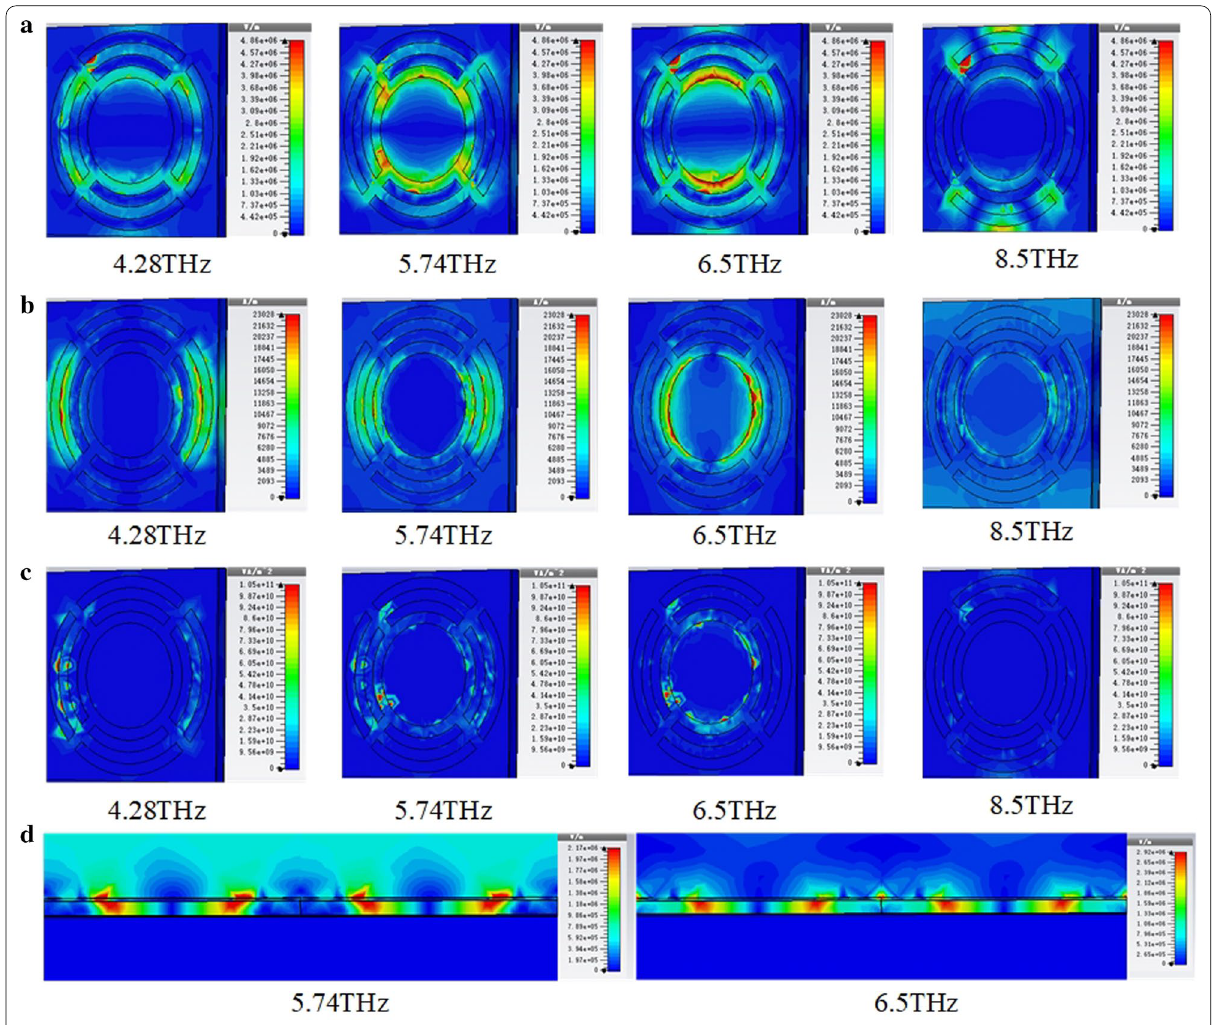
Fig. 4 Top view of electric field density distribution ( a ), magnetic field density distribution ( b ), power loss ( c ) and sectional view of electric field density distribution ( d ) in the periodic structure of two split-rings combined with an Al disk at different resonance absorption frequencies. The periodic structure has a thickness of 10 nm. The two split-rings have a ring width of 2 μm, an opening width of 2 μm and an outer radius of 17 μm and 14 μm, respectively. The Al disk has a radius of 9